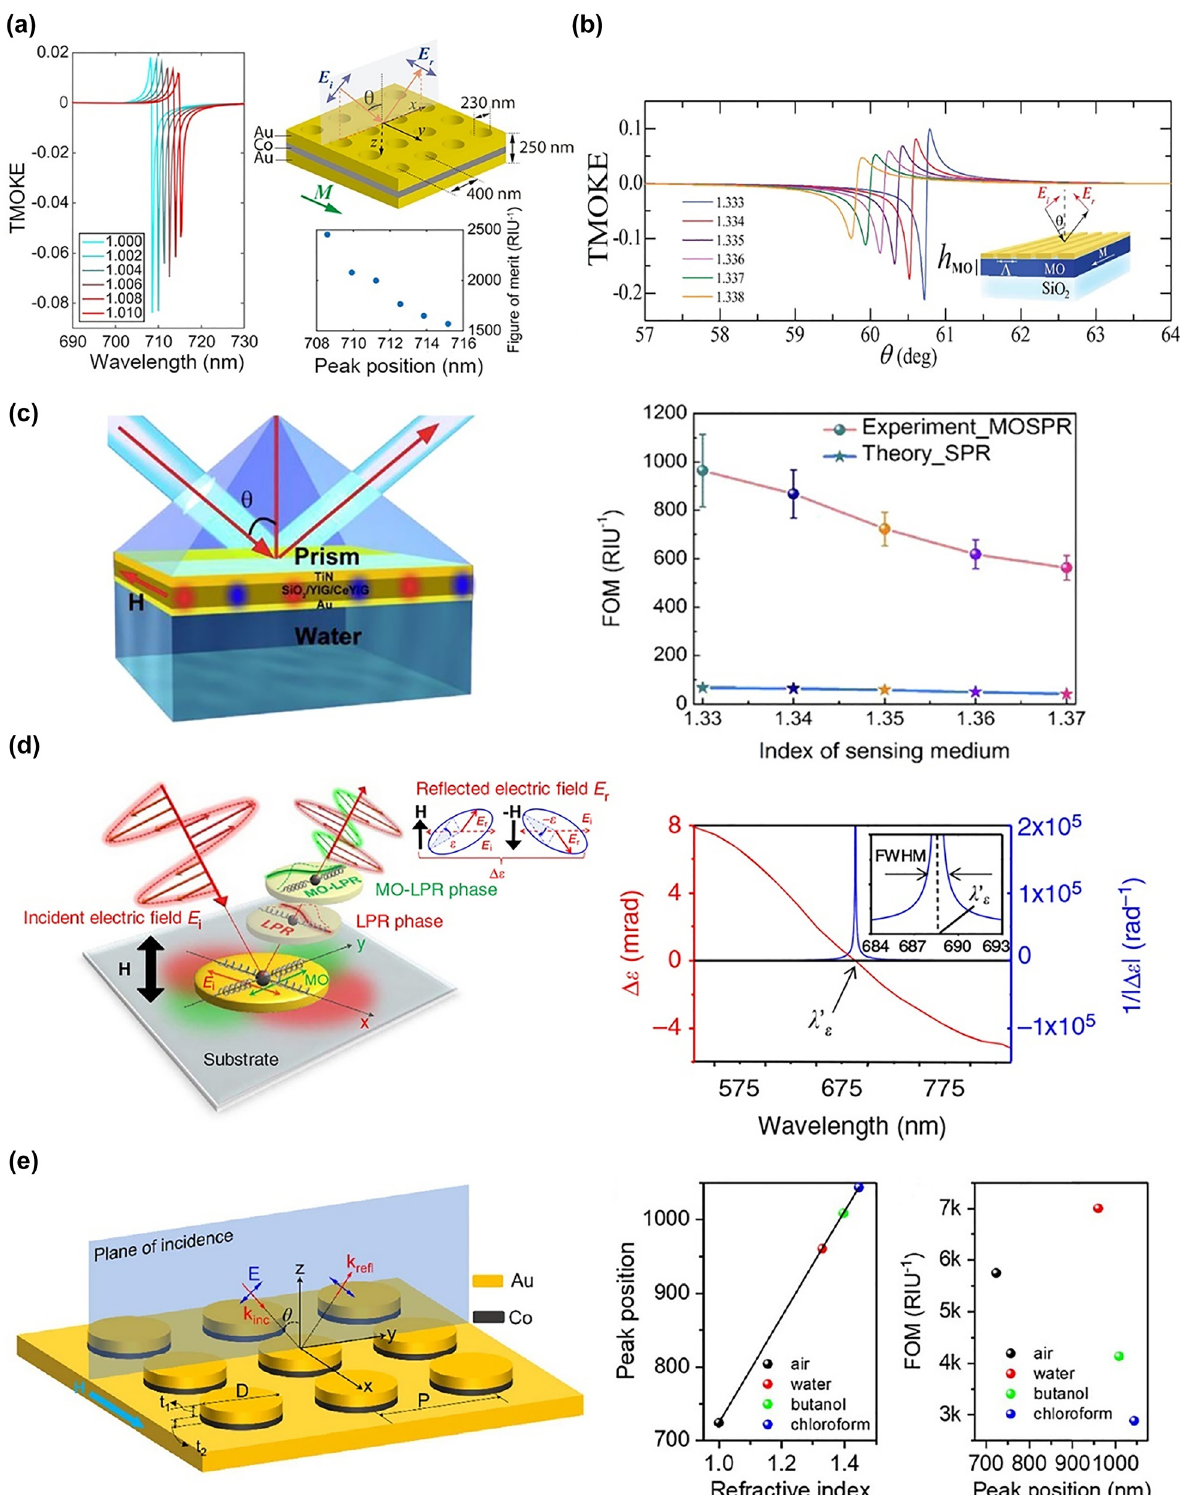
Figure 9: Applications of magneto-nanophotonic devices for bio/chemical sensing. (a) MOSPR biosensors based on the perforated nanoholes. The FOM reaches 2500 RIU − 1 using TMOKE as signal for biosensing. (b) MOSPR biosensors using hybrid Au grating and ferromagnetic metal fi lm. The angular spectra of TMOKE present high sensitivity to the medium index change. (c) MOSPR biosensors based on low loss magnetic oxides. The right fi gure presents the measured FOM as a function of the index